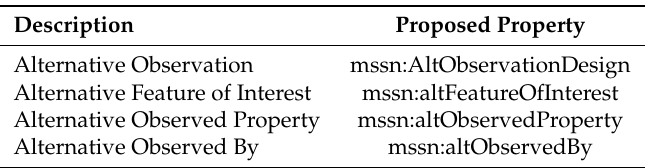
Table 1. Extending and refining